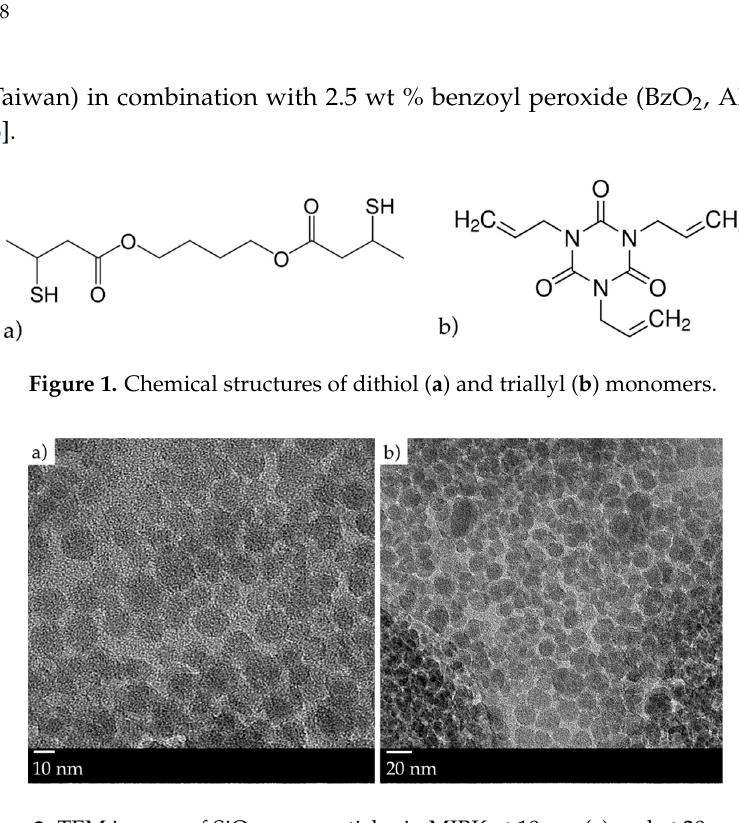
Figure 2. TEM images of SiO 2 nanoparticles in MIBK at 10 nm ( a ) and at 20 nm ( b ).